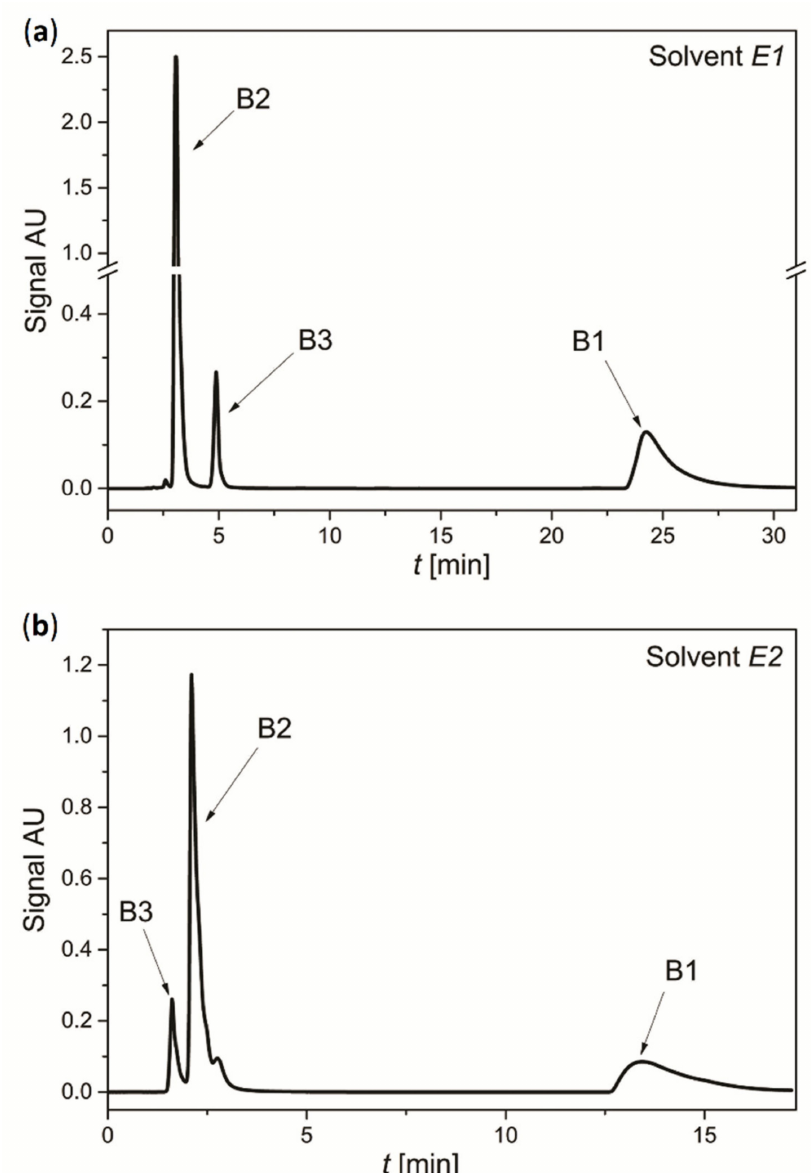
Figure 15. Separation of vitamin mixture obtained using column E and solvent: ( a ) E 1 and ( b ) E 2 as mobile